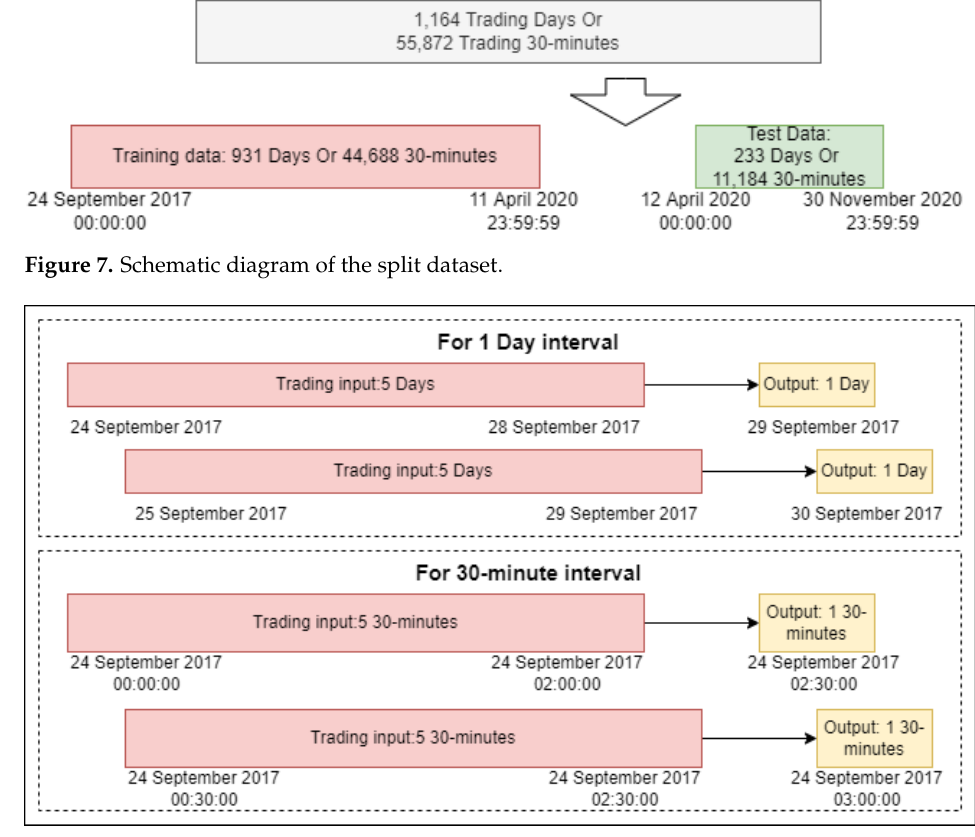
Figure 8. Schematic diagram of the time step window. Table 2. Features and indicators used in the model.